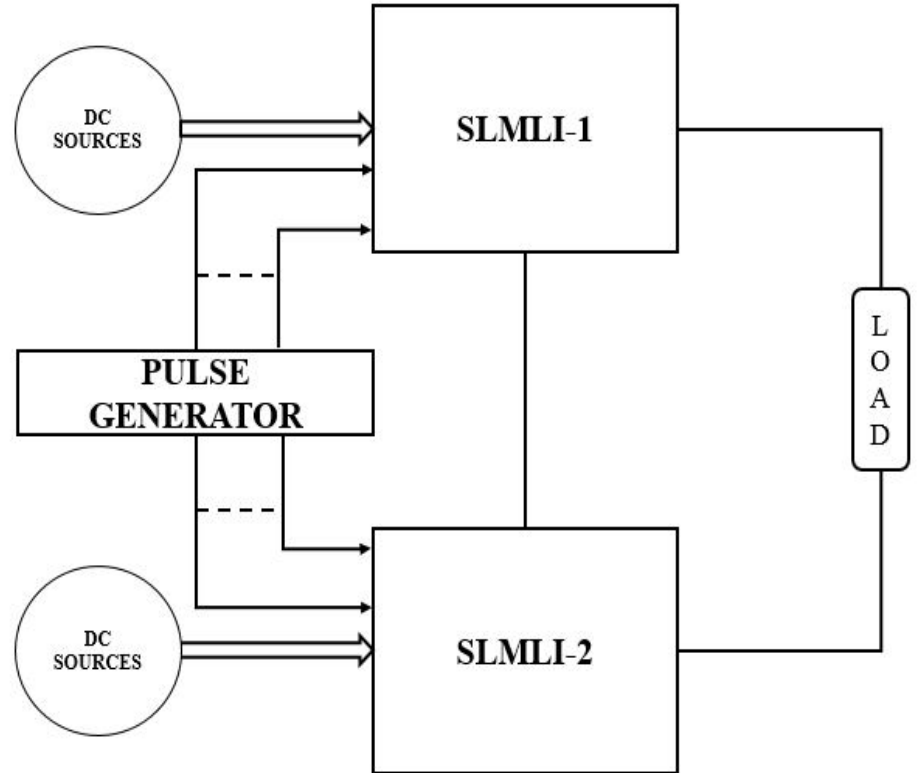
Figure 4. Block diagram of SLMLI.